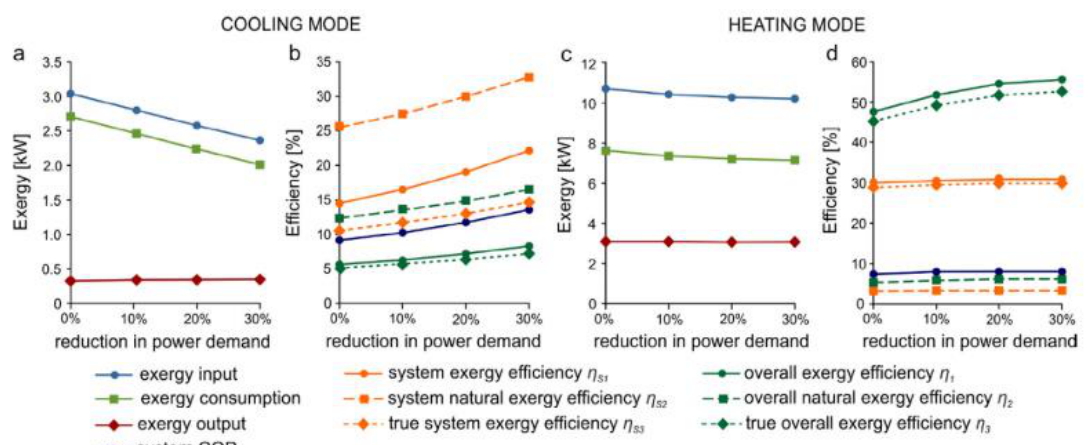
Figure 10. Exergy figures for heating and cooling modes [36]. ( a )Total exergy flows in cooling mode; ( b ) Exergy efficiency in cooling mode; ( c ) Total exergy flows in heating mode; ( d ) Exergy efficiency in heating mode.